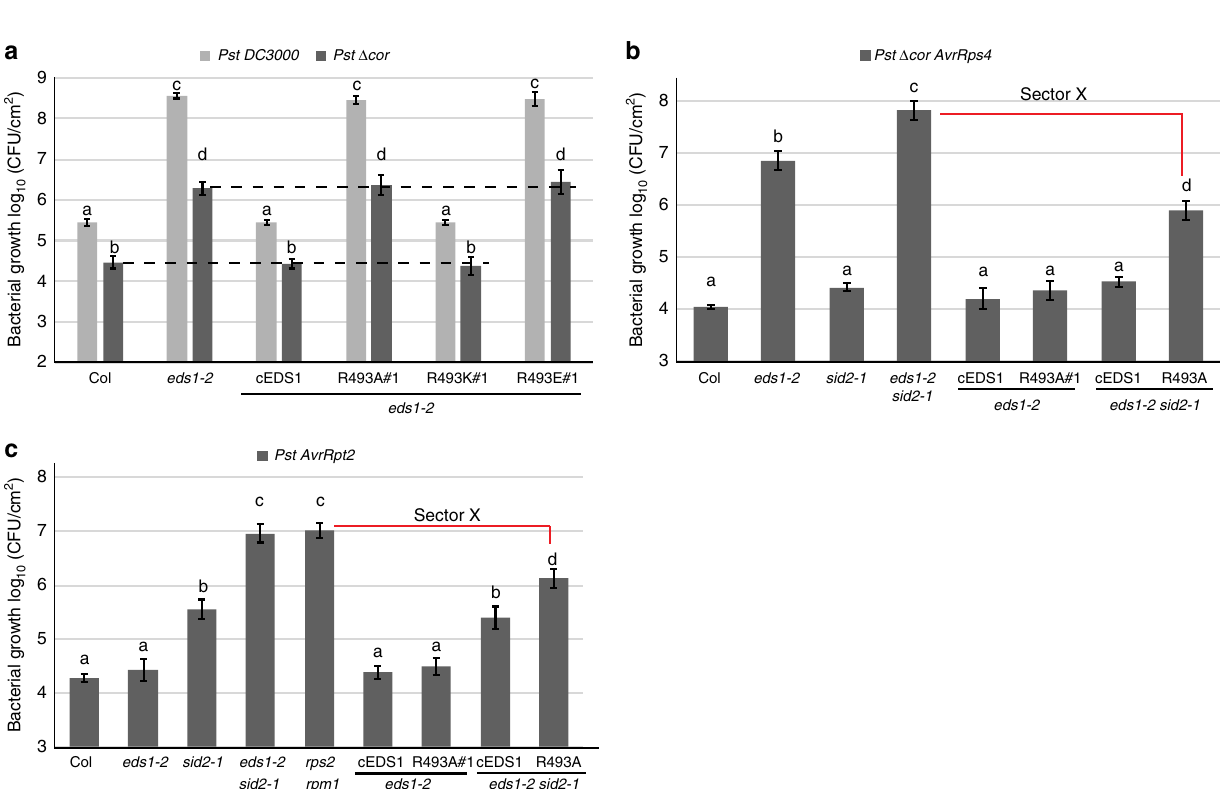
R493A weak function in RRS1S RPS4 ETI.